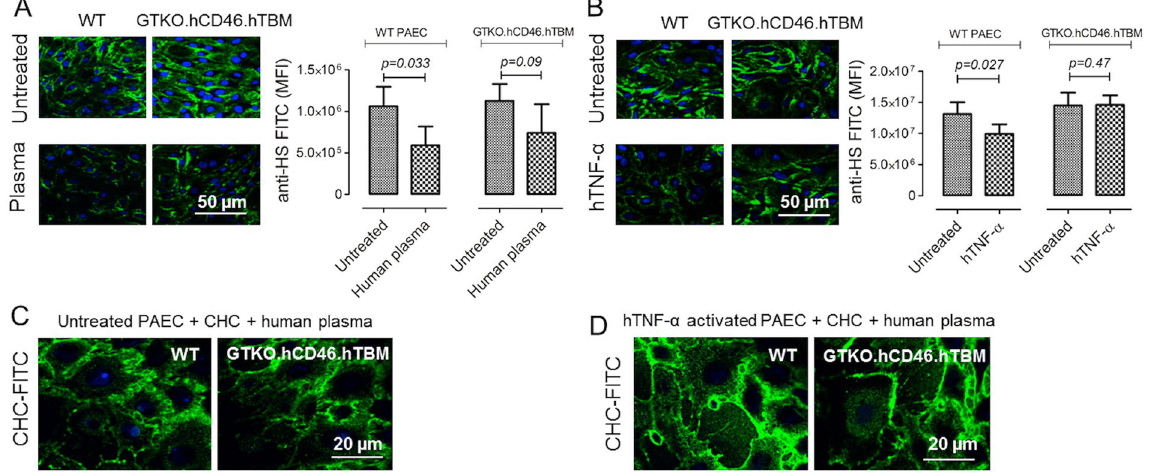
Figure 1. ( A,B ) Heparan sulfate (HS) expression on untreated and human plasma-treated PAEC. WT and GTKO.hCD46.hTBM PAEC were treated either with ( A ) 10% human plasma for 4 hrs or ( B ) 100 ng/ml hTNF α for 2 hrs and stained for HS expression (green) and nuclei (blue) and visualized by confocal microscopy; mean fluorescence intensity (MFI) of anti-HS FITC was quantitated using Image J software. Incubation of WT PAEC with human plasma or hTNF α induced a significant loss of HS expression (both p < 0.05). GTKO.hCD46.hTBM PAEC incubated with human plasma for 4 hrs displayed some loss of HS (not statistically significant), whereas treatment with hTNF α showed no change in HS expression. Statistical significance was measured by unpaired t-test; data are mean ± SD of three independent experiments. Scale bar: 50 µ m. ( C,D ) Persistence of FITC-CHC binding to PAEC after 4 hrs treatment with human plasma. ( C ) Untreated or ( D ) hTNF α -treated (100